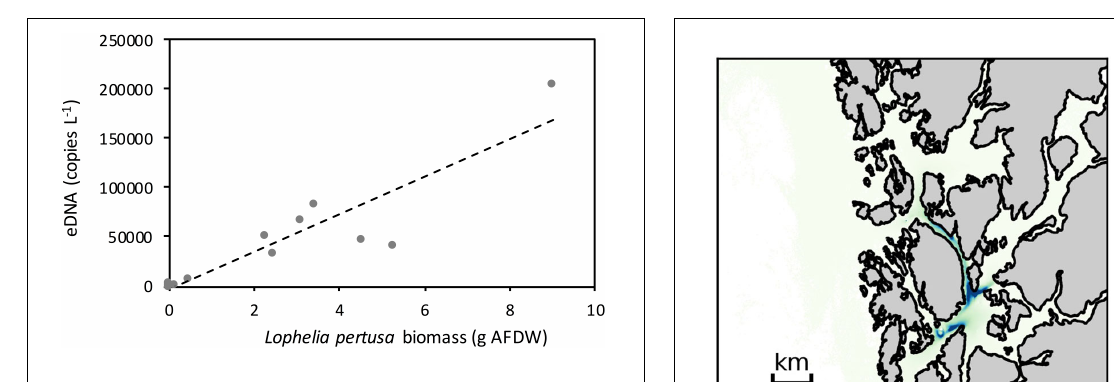
FIGURE 3 | Concentration of the targeted Lophelia pertusa eDNA fragment in 80 liter flow through tanks containing decreasing biomass of corals. A linear regression is fitted for the concentration of eDNA in the water and biomass of corals in the tanks ( y = 19015x–2579) (Spearman rank correlation coefficient = 0.85, p < 0.001). Temperature = 10 o C and salinity = 33 . Ash free dry weight ratio to dry weight ratio of whole living coral fragments was (cid:104) 0.03. FIGURE 4 | Simulated distribution of eDNA particles (averaged over all depths) dispersed from all known cold-water coral occurrences in the study area. Simulations were conducted for the time period 10–23 March 2019, and included releasing 100 particles every hour from each reefs with the trajectories of the particles calculated using passive drift, with no active behavior in the vertical nor in the horizontal. The particles were parameterized as super individuals, reflecting the size of its origin reef grouped into three categories given as relative reef size in Figure 1 and Table 2